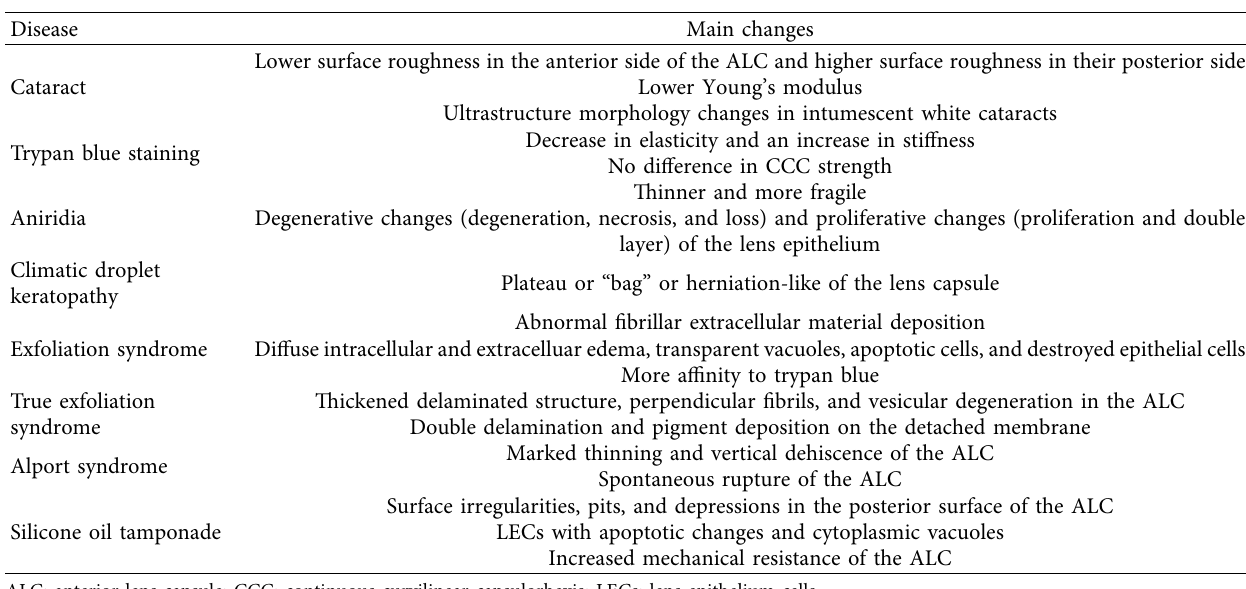
Table 1: Pathological changes of the ALC in different